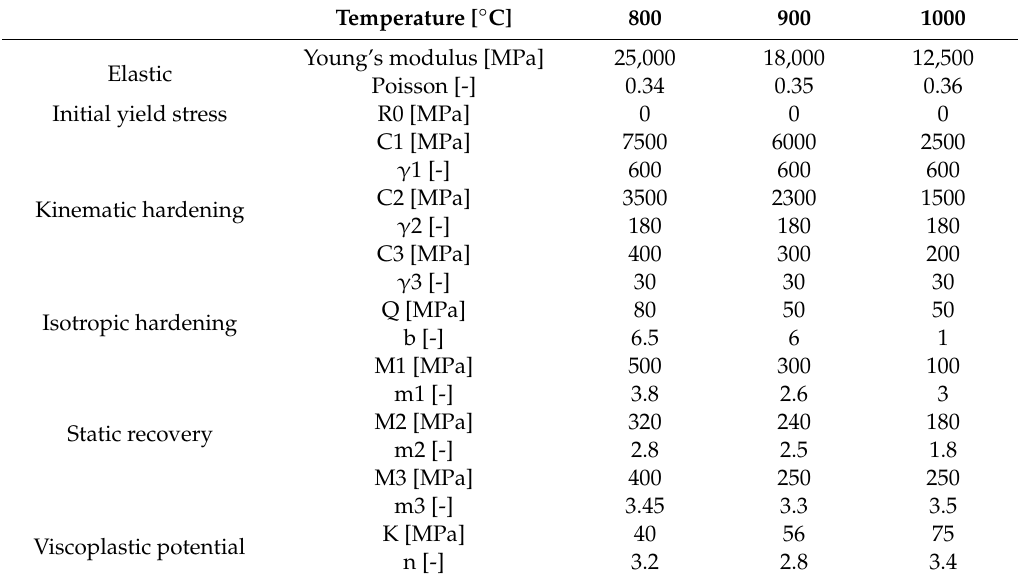
Table 2. Material model parameters for the three representative temperatures 800, 900, and 1000 ◦